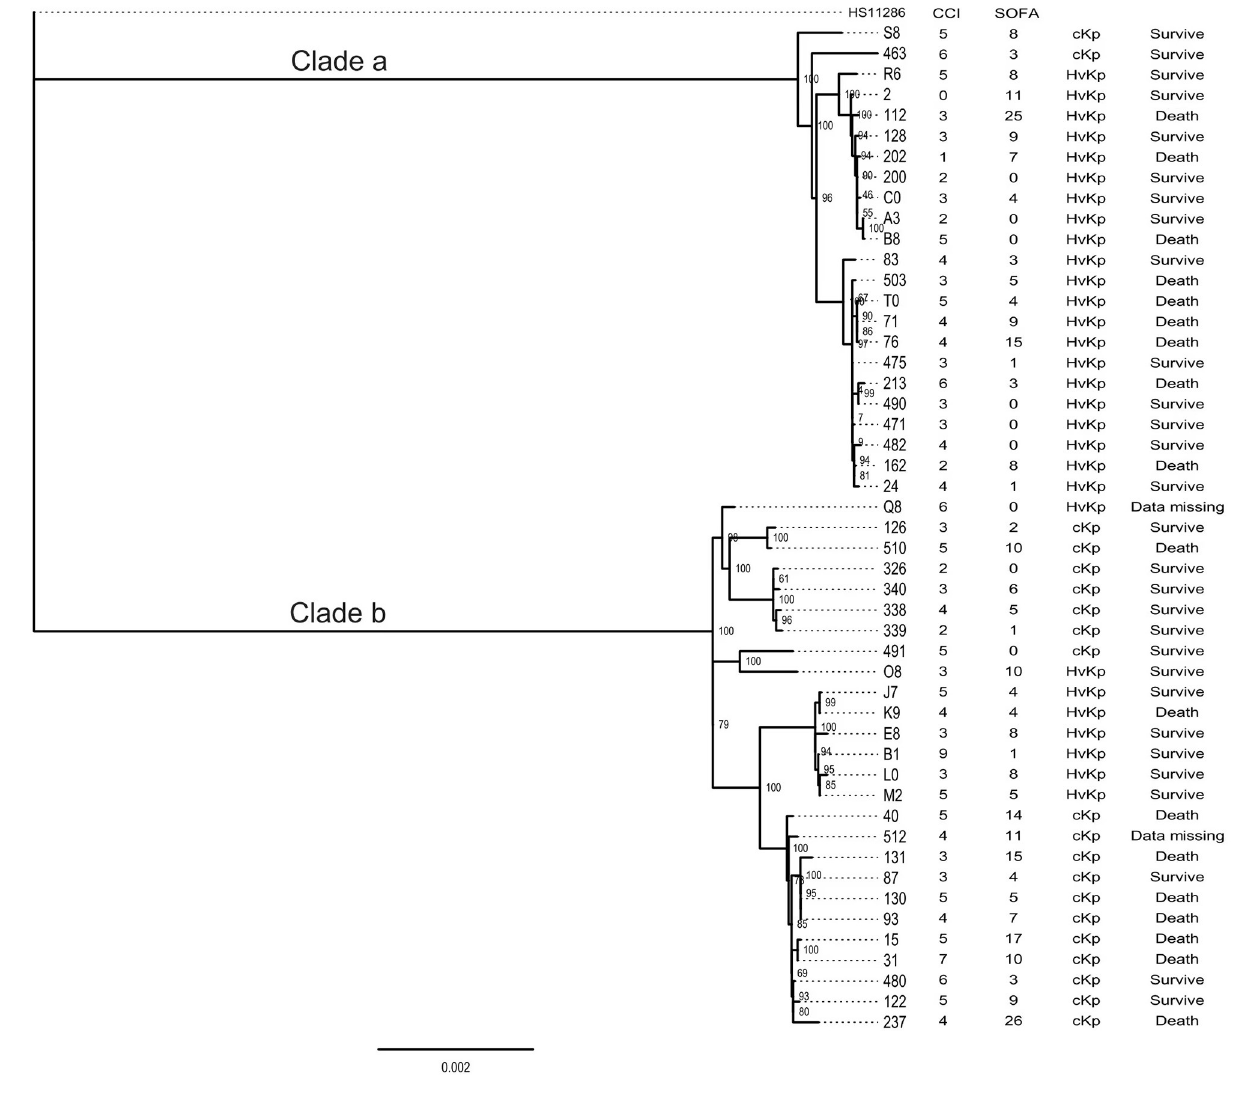
FIGURE 2 | The phylogenetic tree of ST11 strains isolated in this